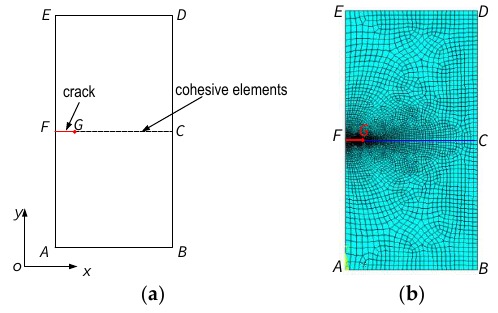
Figure 3. Geometry and FE mesh model: ( a ) geometry model; ( b ) mesh model.